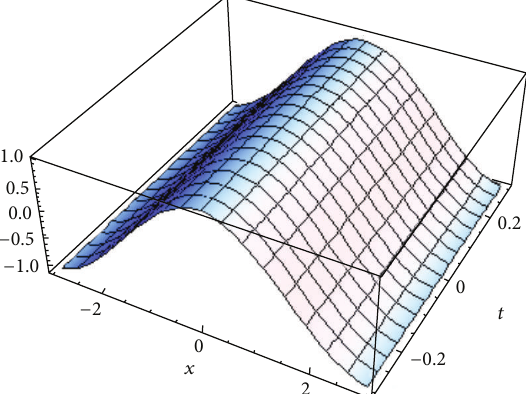
Figure 2: 3D, exact solution of 𝛽(𝑥,𝑡) at 𝑡 = 0.1 .